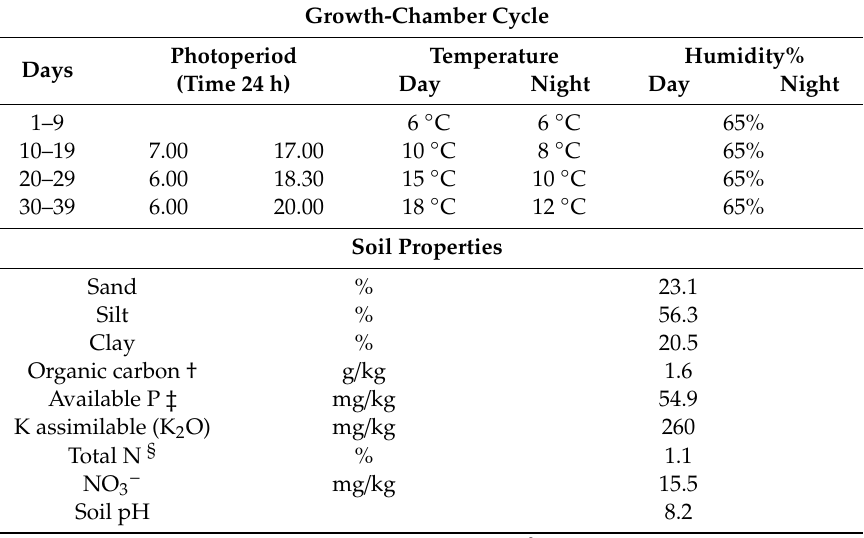
Table 1. Growth-chamber cycle and physical and chemical properties of the soil used for the experiment. Growth-Chamber